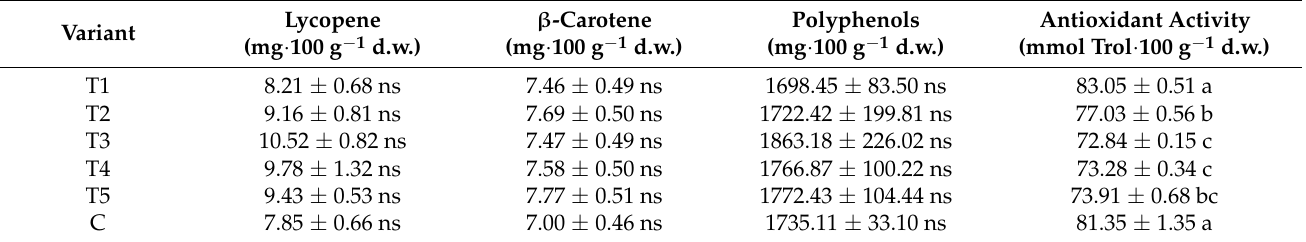
Table 5. The antioxidant status of tomato